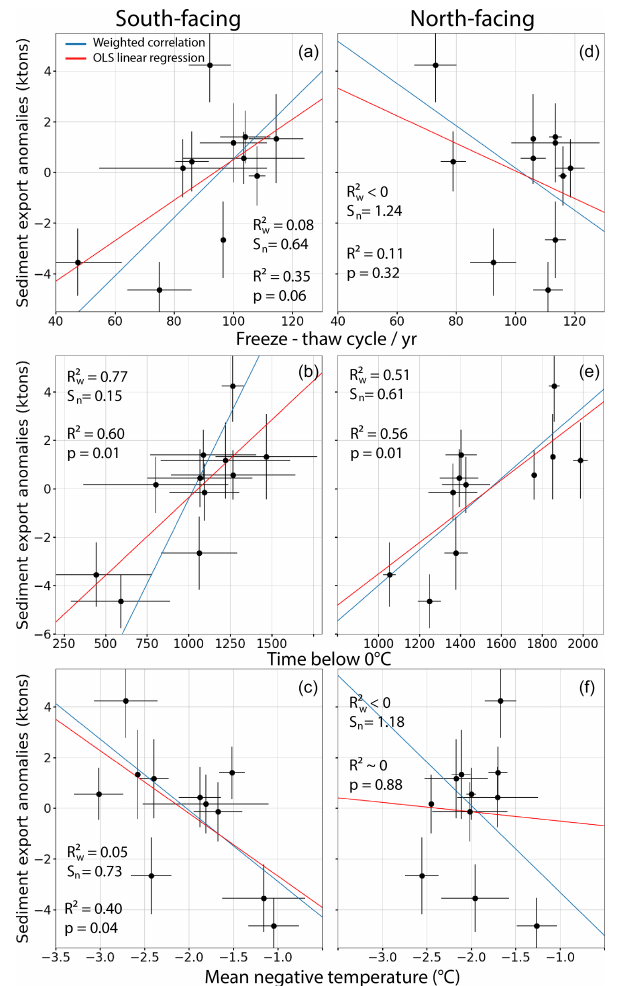
Figure 9. Linear regression analysis between sediment export anomalies and (a, d) number of freeze–thaw cycles per year, (b, e) time spent below 0 ◦ C, and (c, f) mean negative temperature. The left column shows regressions for the south-facing slope and the right column for the north-facing slope. Error bars and red and blue regression lines are as in Fig. 8. Weighted determination co- efficients R 2 w and associated normalized goodness-of-fit indicators S n are indicated for each weighted regression. The standard R 2 and associated p value indicate the significance of the ordinary least- squares (unweighted)